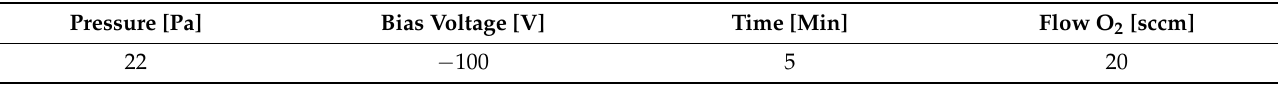
Table 1. Parameters of the process of etching the surface of ceramics with oxygen plasma by the RF PACVD